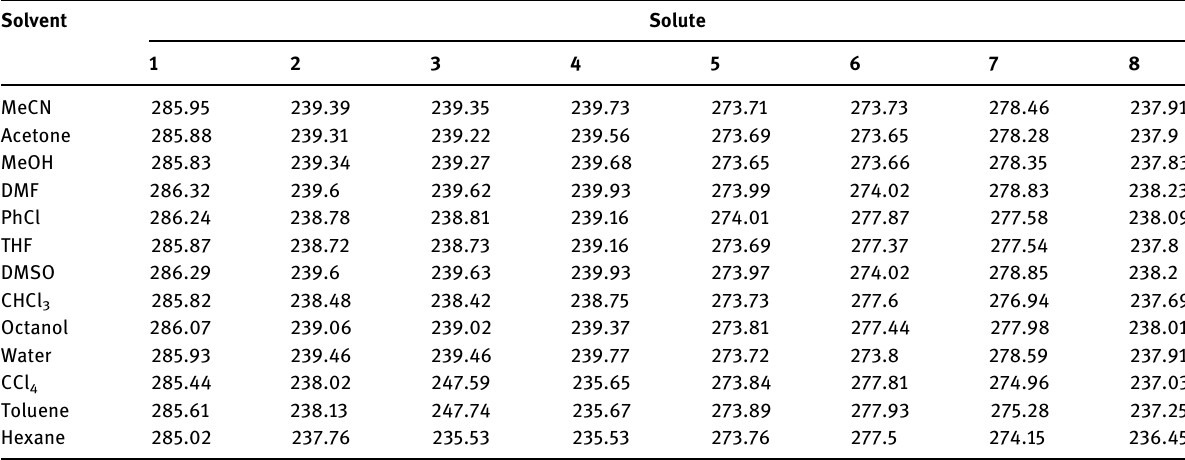
Table 8: Calculated values of λ max ( nm ) for azoles 1 – 8 at the MPW1PW91/6 - 311 ++ G ( 2d,3p ) //MPW1PW91/6 - 31G ( d,p ) level of theory using di ff erent solvents and PCM solvation model